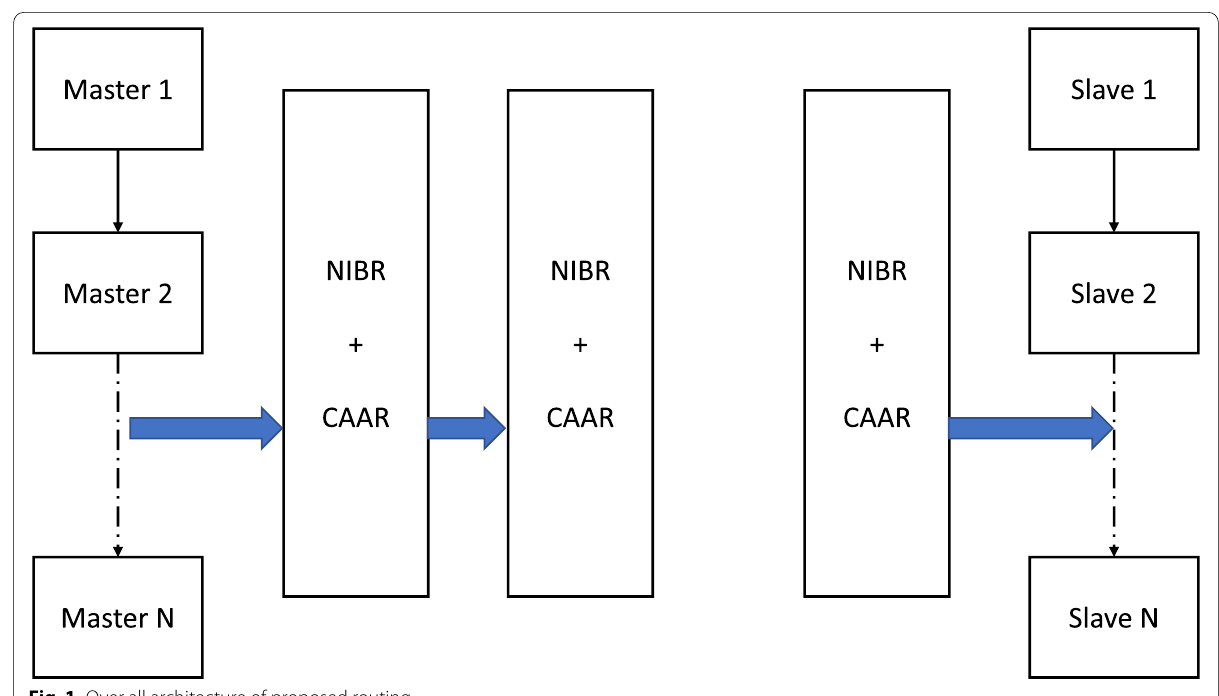
Fig. 1 Over all architecture of proposed routing